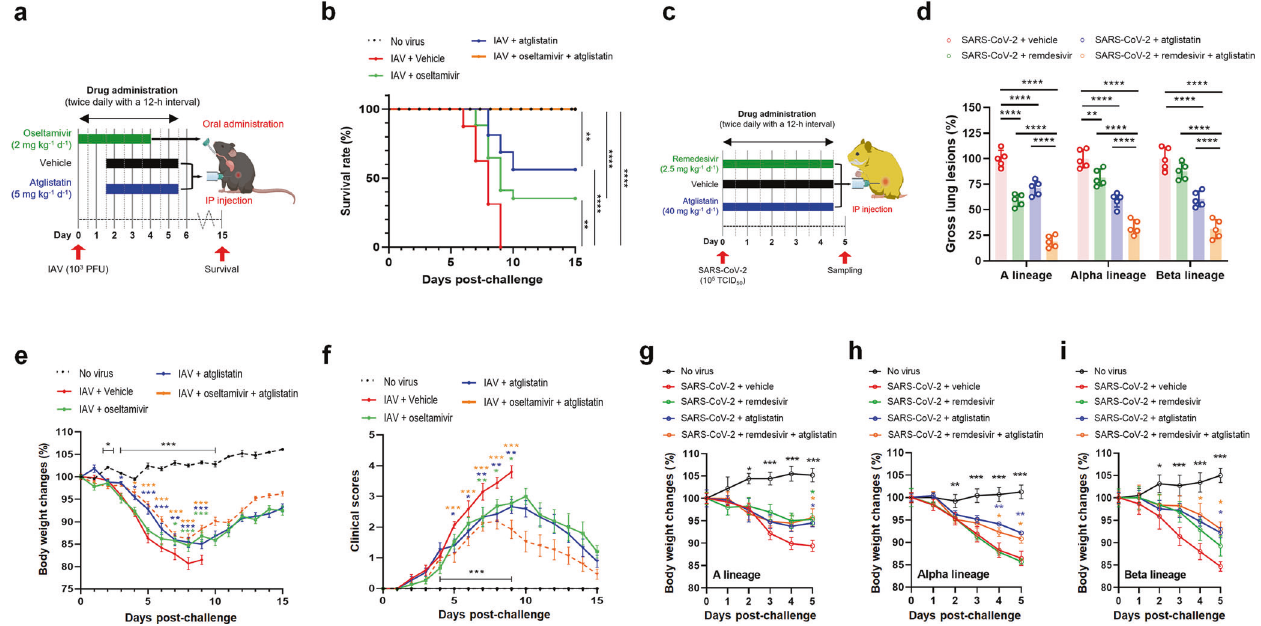
Fig. 6 Synergistic in vivo antiviral effects by combination therapy. a Scheme of chemical administration of atglistatin and oseltamivir, either individually or in combination, twice daily for 4 consecutive days after challenge with 10 3 PFU of mouse-adapted IAV PR8 strain to mice ( n = 16). b Survival rates (expressed as percentages) of IAV-challenged mice after treatment. c Scheme of chemical administration of atglistatin and remdesivir, either individually or in combination, twice daily for 4.5 consecutive days after challenge with 10 5 TCID 50 of SARS-CoV-2 KCDC03 (closely related to early Chines strains), KDCA51463 (Alpha lineage with British variants), and KDCA55905 (Beta lineage with South African variants) to Syrian hamsters ( n = 5). d Reduction in gross lung lesions in Syrian hamsters challenged with each strain by combination therapy with atglistatin and remdesivir. e Effect of treatments on the recovery of body weight in each group. f Effect of treatments on the reduction in clinical signs in each group. g – i Effect of combination therapy of atglistatin and remdesivir on the recovery of body weight in Syrian hamsters ( n = 5) challenged with SARS-CoV-2 KCDC03 ( g ), KDCA51463 ( h ), and KDCA55905 ( i ). Results are presented as arithmetic means ± SD. * P < 0.05; ** P < 0.01; *** P < 0.001, **** P < 0.0001, one-way analysis of variance with Tukey ’ s correction for multiple